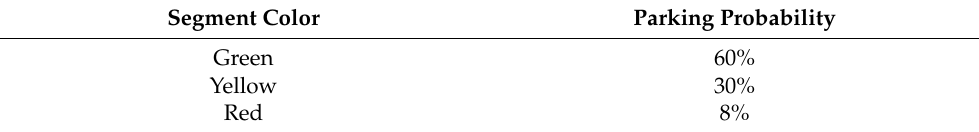
Table 3. Color Label